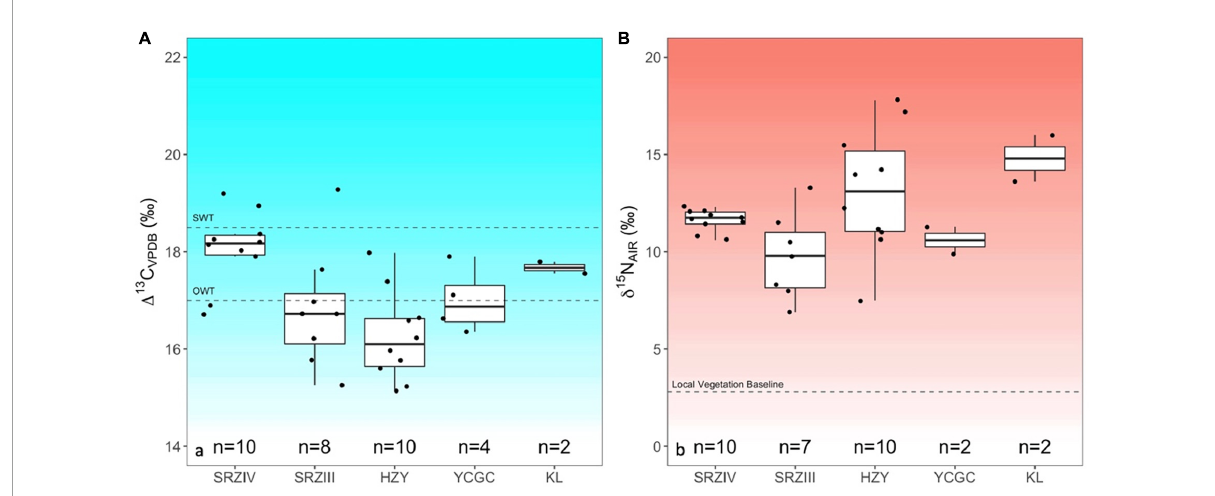
FIGURE4 (A) (cid:49) 13 C and (B) δ 15 N values measured in charred barley grains from eastern Tianshan complexity (ETC) sites. Dashed lines represent the threshold of “Optimal Water Status” (OWT) and “Superfluous Water Status” (SWT) for barley (Wallace et al., 2013; Vaiglova et al., 2020), and the estimated δ 15 N baseline of local vegetation using average δ 15 N values of archaeological herbivores (Ling et al.,